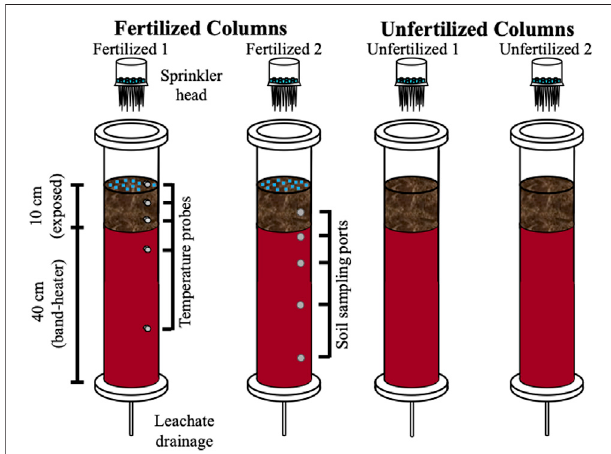
FIGURE 1 | Schematic diagram of soil columns. Four columns were packed with agricultural soil, with two columns amended with fertilizer. A sprinkler head allowed for application of precipitation which is then collected as leachate after fl ow-through. Temperature probes, at depths of +2.5, − 3.5, − 7.0, − 15.5,and − 33.0relativetothesoilsurfacewereusedtotrackthe simulated temperature gradient across depth created by the environmental chamber and insulating band heater (instrumented and indicated on Fertilized 1 column, not present in other three columns). Ports at depths of − 5, − 11, − 18,and − 38 cmwereusedtosampleforsoil(indicatedonFertilizer2column but ports were present on all four